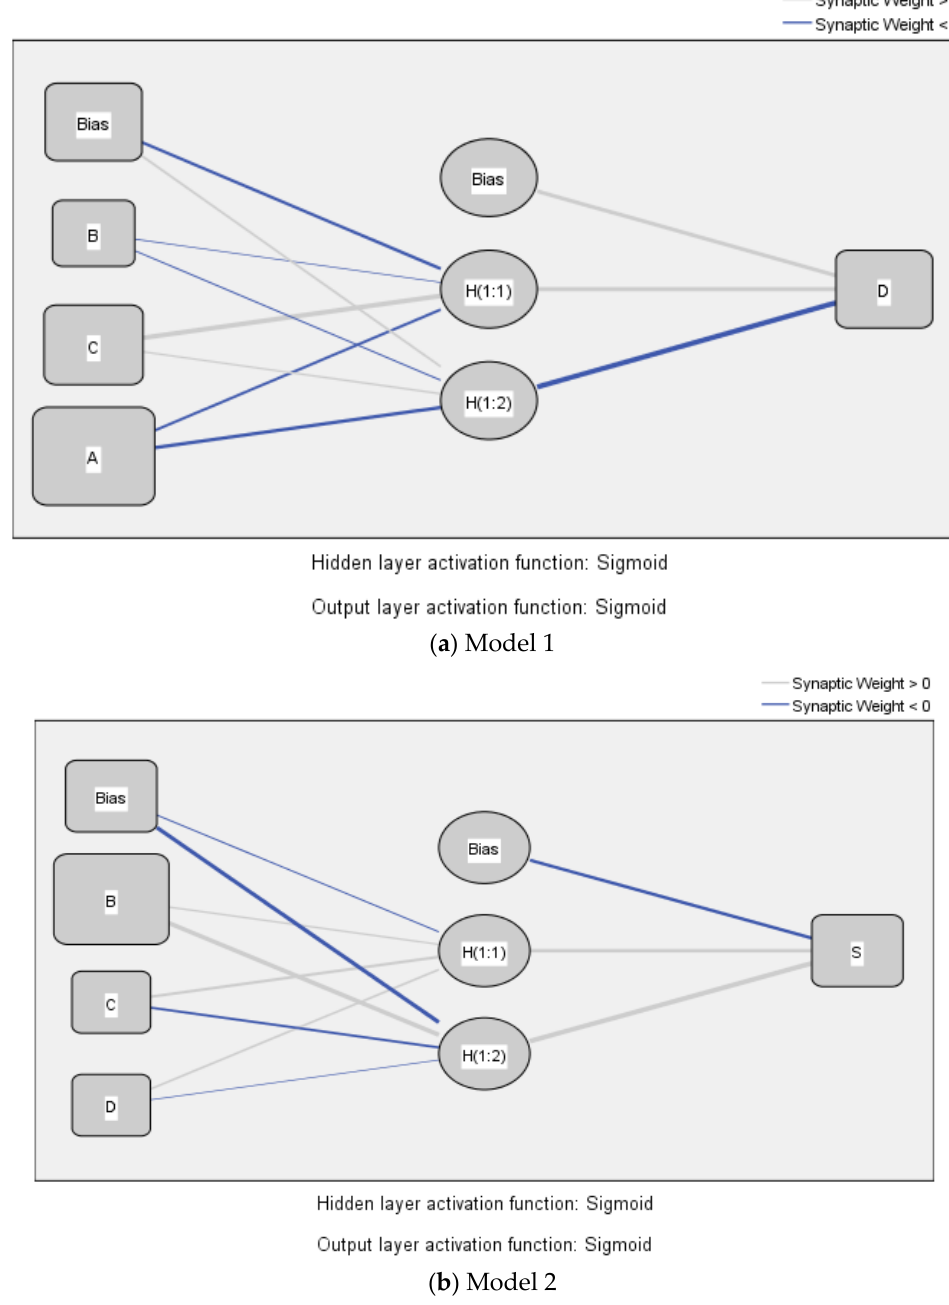
Figure 4. ANN models. Figure 4. ANN Table 11. RMSE values of ANNs.